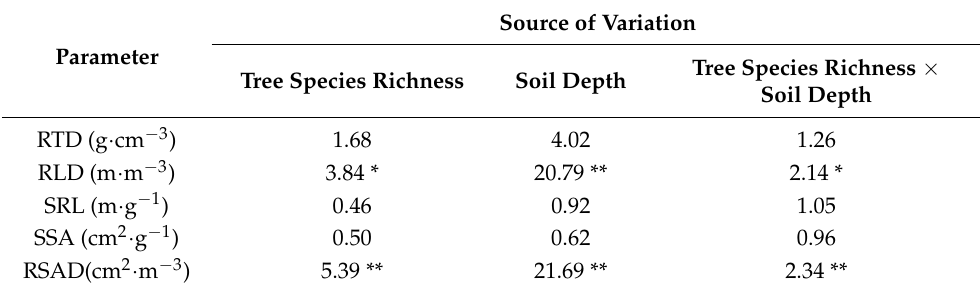
Table 2. Results of ANOVA of the effects of tree species richness and soil layers on fine root morpho- logical